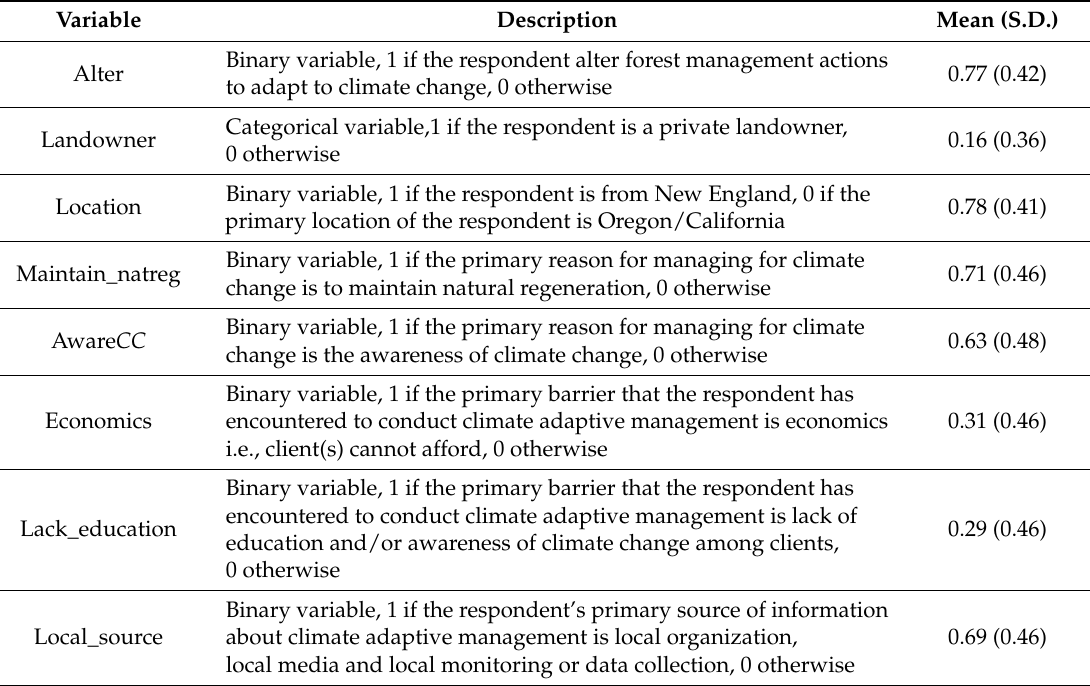
Table 1. Summary of the variables used in the logistic regression model of survey respondents, including mean and standard deviation (S.D.).